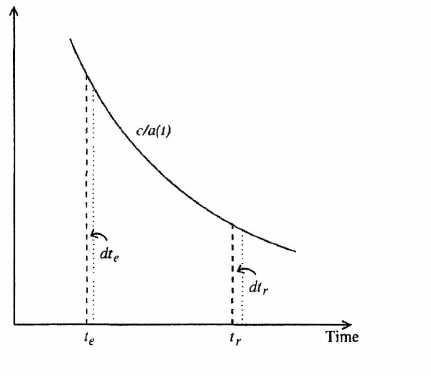
Figure 12. Diagrammatic scheme for deriving redshift. The slices are very narrow, so the area is just the area of a rectangle, i.e., width times height,